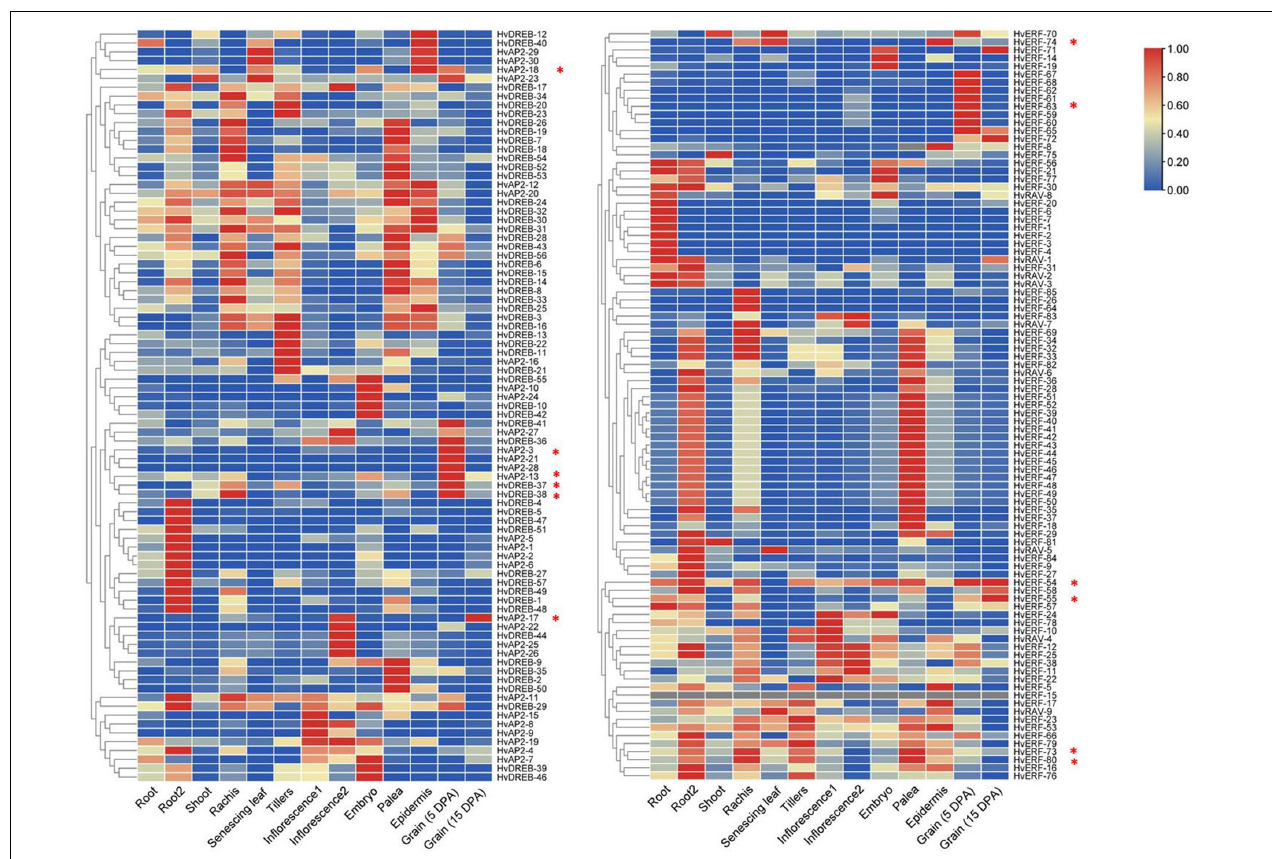
FIGURE 5 | Heatmaps of expression profiles for HvAP2/ERF genes at different developmental stages for eight tissues in barley. The color scale represents the expression values. * Indicates the 12 genes selected for qRT-PCR verification. Root (10 cm seedlings), Root 2 (4 weeks seedling), Shoot (10 cm seedlings), Rachis (5 weeks pa), Senescing leaf (2 months), Tillers (third internode), Inflorescence-1 (0.5 cm), Inflorescence-2 (1–1.5 cm), Embryo (germinating), Palea (6 weeks pa), Epidermis (4 weeks), Grain (5 DPA) and Grain (15 DPA), DPA: days postanthesis, pa: